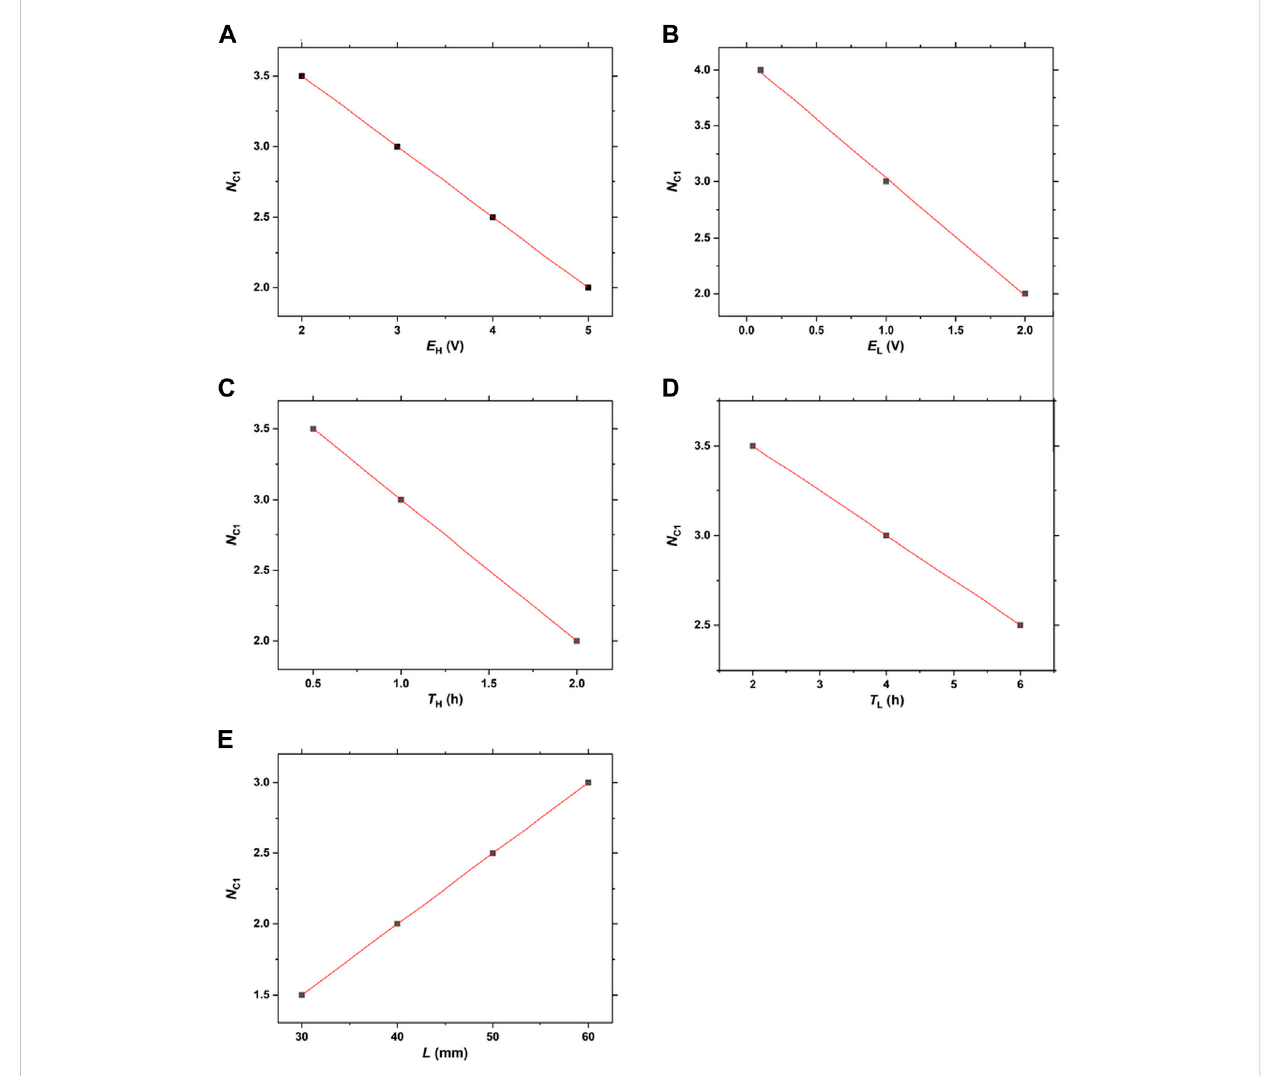
FIGURE 11 Linear correlations between (A) N C1 and E H (B) N C1 and E L (C) N C1 and T H (D) N C1 and T L , and (E) N C1 and L